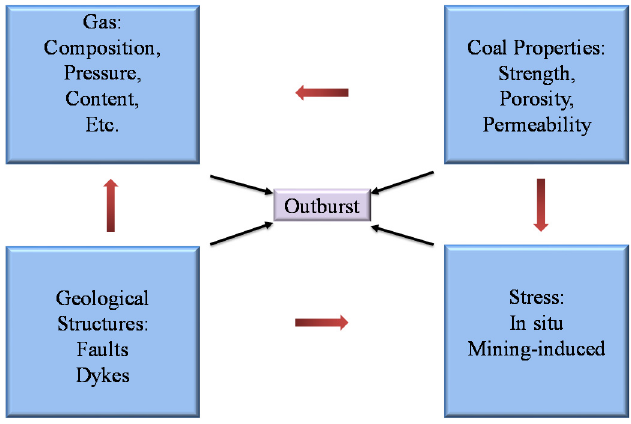
Figure 1. Main factors affecting coal and gas outbursts [4].